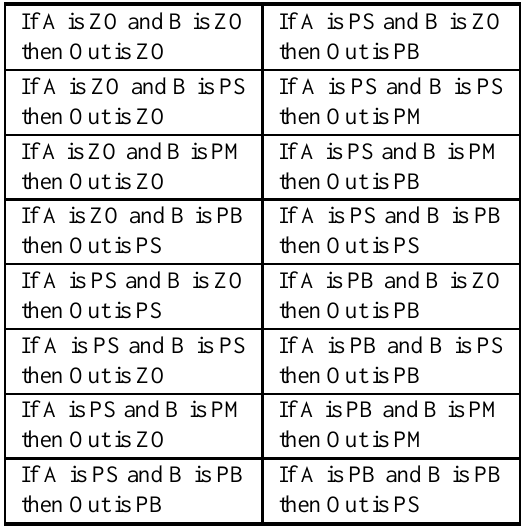
Fig. 11. Defuzzified values for ‘up’ command and non-command with five different users Table 4. Fuzzy rules for ‘up’